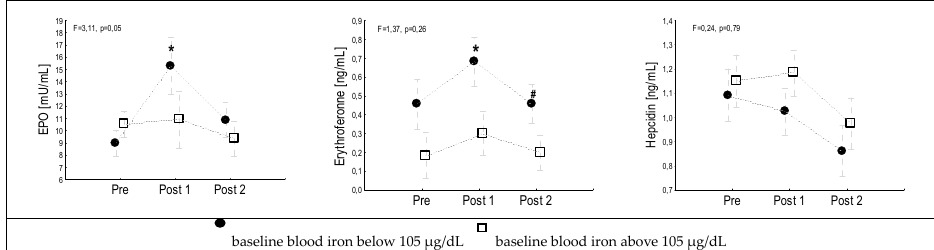
Figure 1. Blood iron levels determine the e ff ect of marathon running on hormones involved in the iron metabolism. Legend: Pre—before the run, Post1—at the finish line, Post 2—9 ± 2 days after the run; * significantly di ff erent from the Pre measurement, # significantly di ff erent from the Post 1